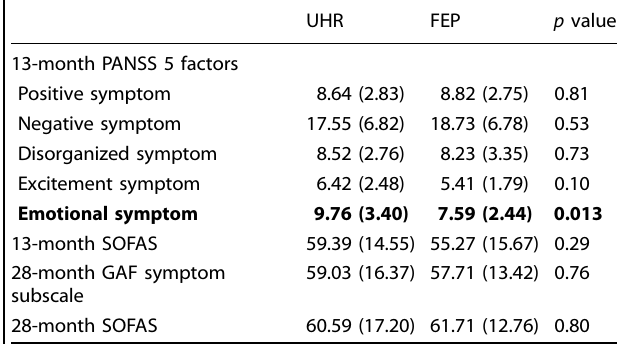
Table 3. Clinical outcomes in the UHR and FEP